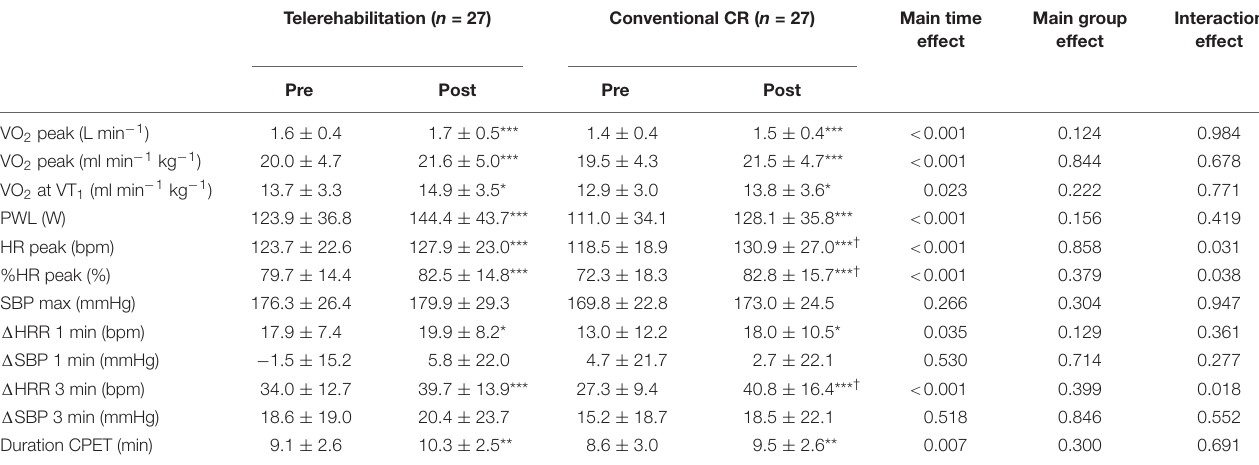
TABLE 2 | Effect of 3-week exercise training on cardiorespiratory parameters between telerehabilitation and conventional cardiac rehabilitation